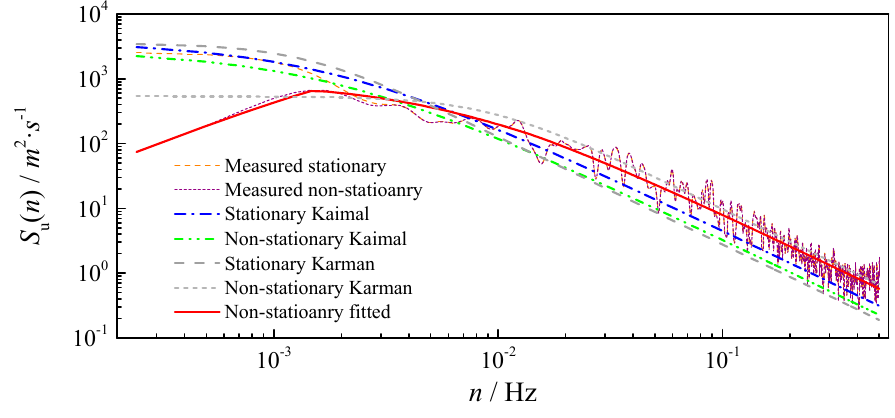
Figure 11. Comparison between measured power spectral densities and empirical models.